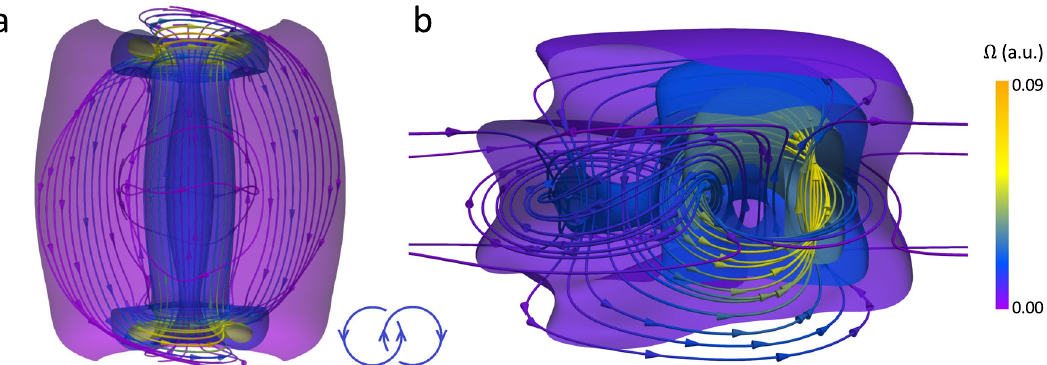
Fig. 3 Interlinked streamlines of skyrmion number density in magnetic Hopf solitons. Skyrmion number density Ω shown by streamlines and magnitude isosurfaces in Hopf solitons stabilized at e B ¼ 0, e K u ¼ 1 ( a ) and e B ¼ 0 : 3, e K u ¼ 0 : 1 ( b ), respectively. Cones on the streamlines indicate the local orientation of Ω . The schematic in a shows that each pair of closed streamlines has a linking number + 1.